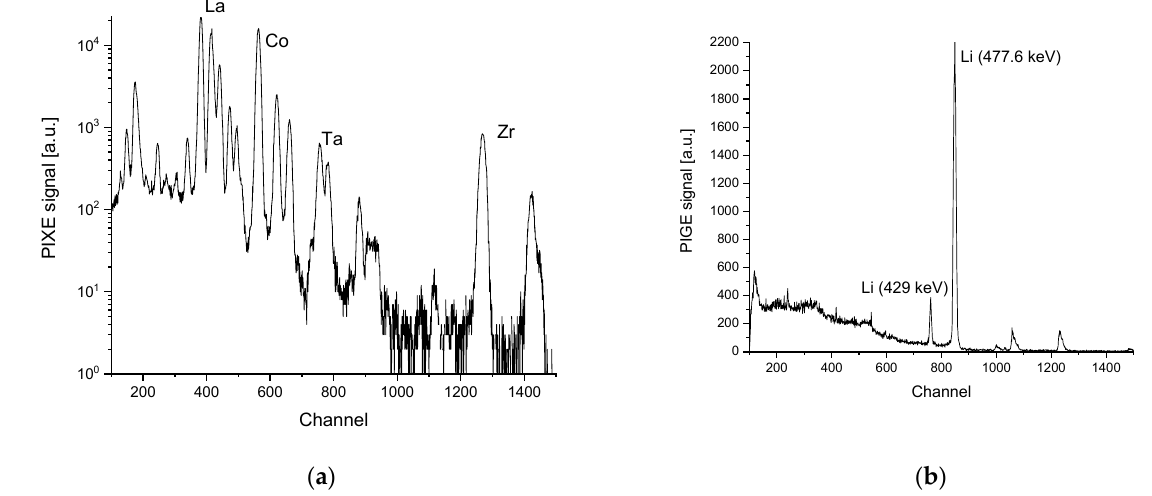
Figure 10. Cumulative (time and space) characteristic x-ray (PIXE, a ) and gamma ray spectrum (PIGE, b ) of ceramic ASBs featuring LLZO as solid electrolyte and LCO as cathode active material.